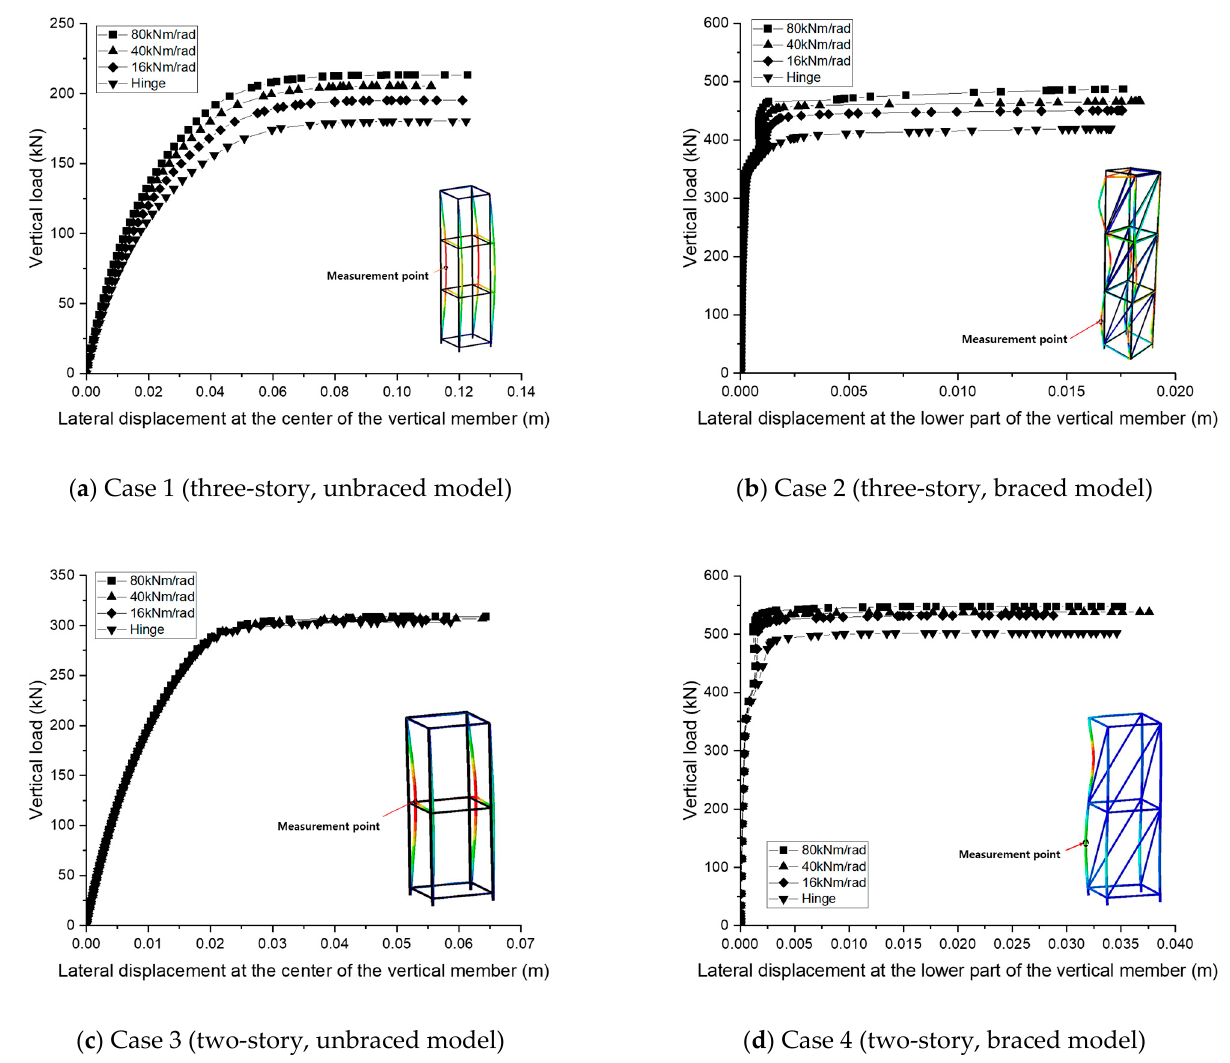
Figure 18. Load–displacement curve of the vertical member in buckling.